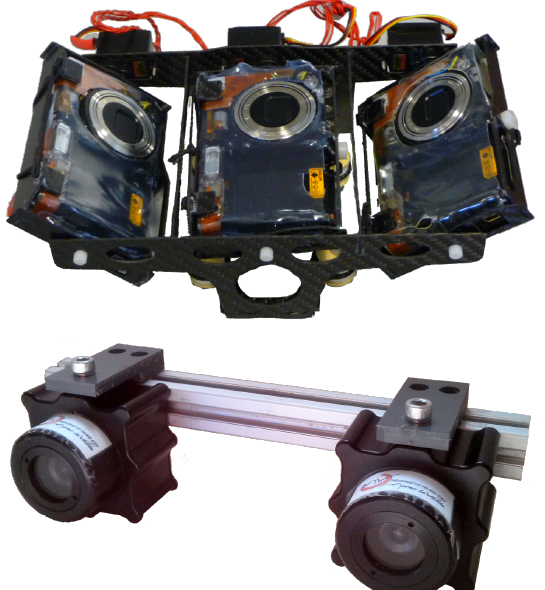
Figure 3: The developped payloads. Top: the tri-camera sen- sor, used on the Faucon Noir UAV. Bottom: the binocular stereo- scopic rig, currently used on an underwater robot (sealed hous- ings can be removed when the rig is used on a flying vehicle).